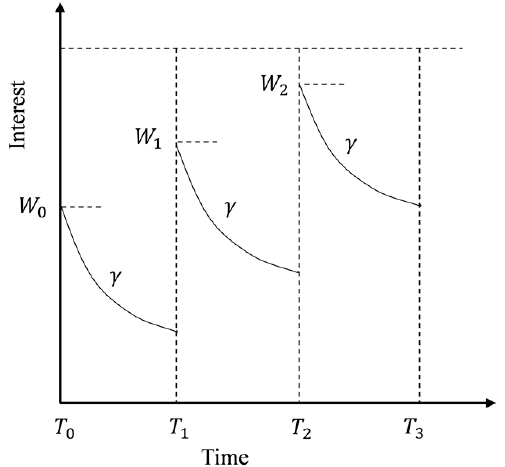
Figure 2. Interest decay curve caused by multiple check-ins.